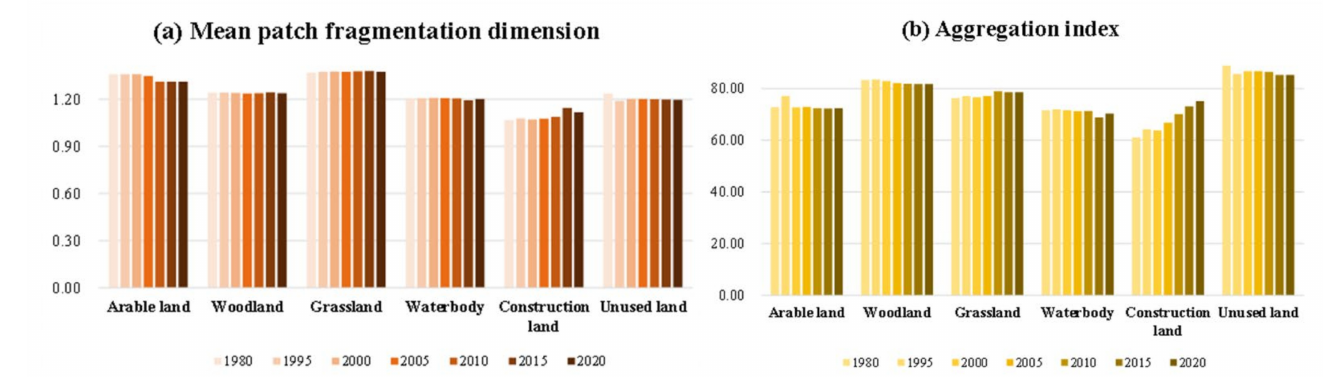
Figure 3. The landscape pattern changes for diverse land-use